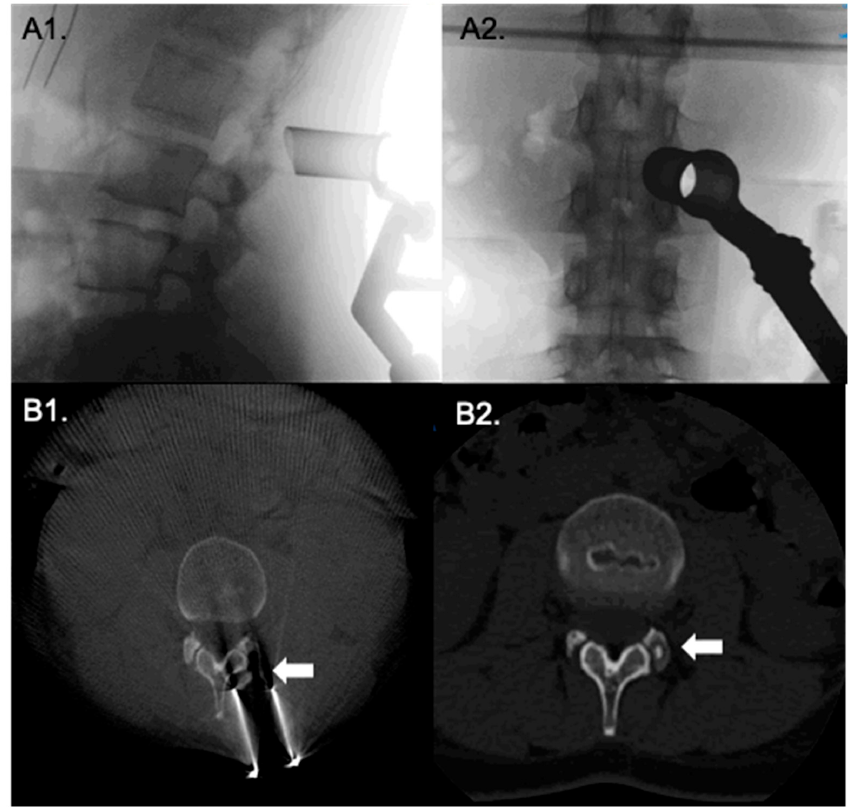
Figure 1. Direct posterior approach to to osteoid osteoma in the facet joint. Intraoperative fluoroscopy, ( A1 , A2 ), verify correct positioning of the tubular retractor. ( B1 , B2 ) show intraoperative O-Arm CT views before and after tumor removal.